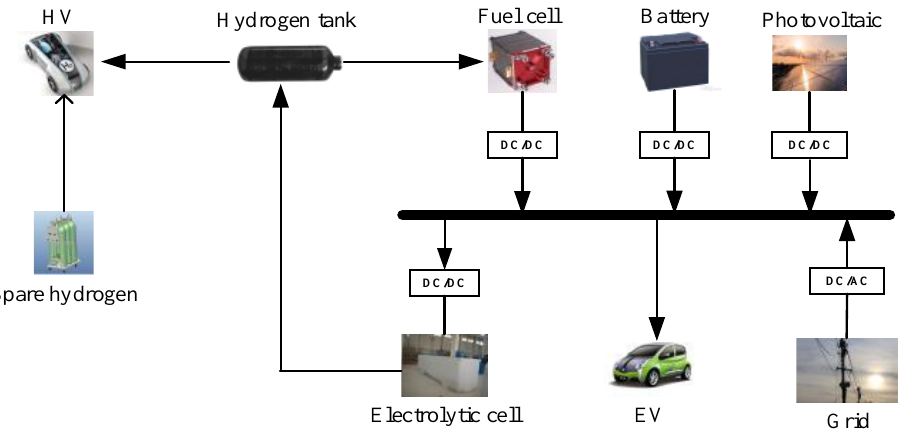
Figure 1. Structure diagram of the integrated charging station.